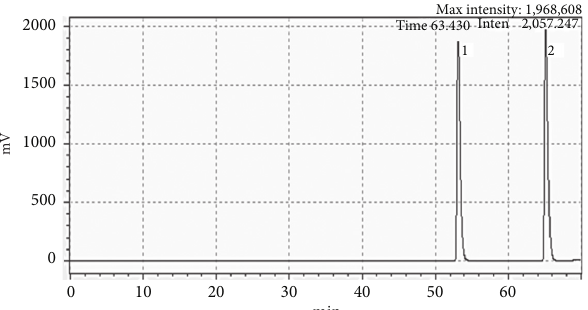
Figure 6: Chromatogram of standard mixture (1: rutin; 2: quercetin).